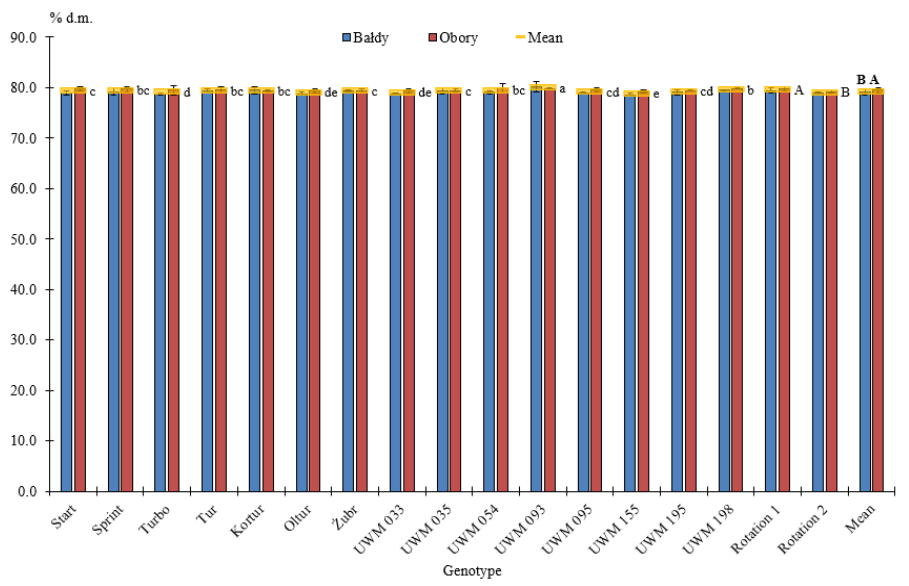
Figure 3. Fixed carbon content in the biomass of 15 willow genotypes obtained at two locations in two consecutive three-year harvest rotations; (legend: see Figure 1).